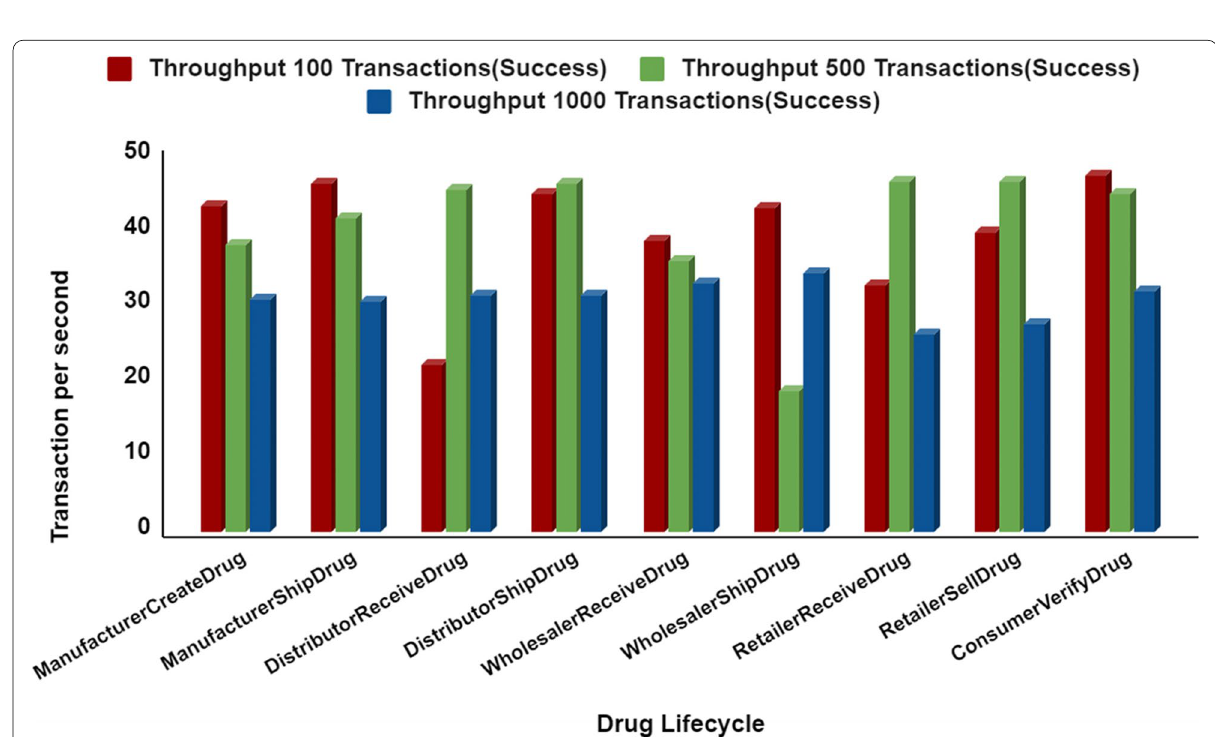
Fig. 11 A Comparative Analysis of Throughput of Three Different Successful Transaction